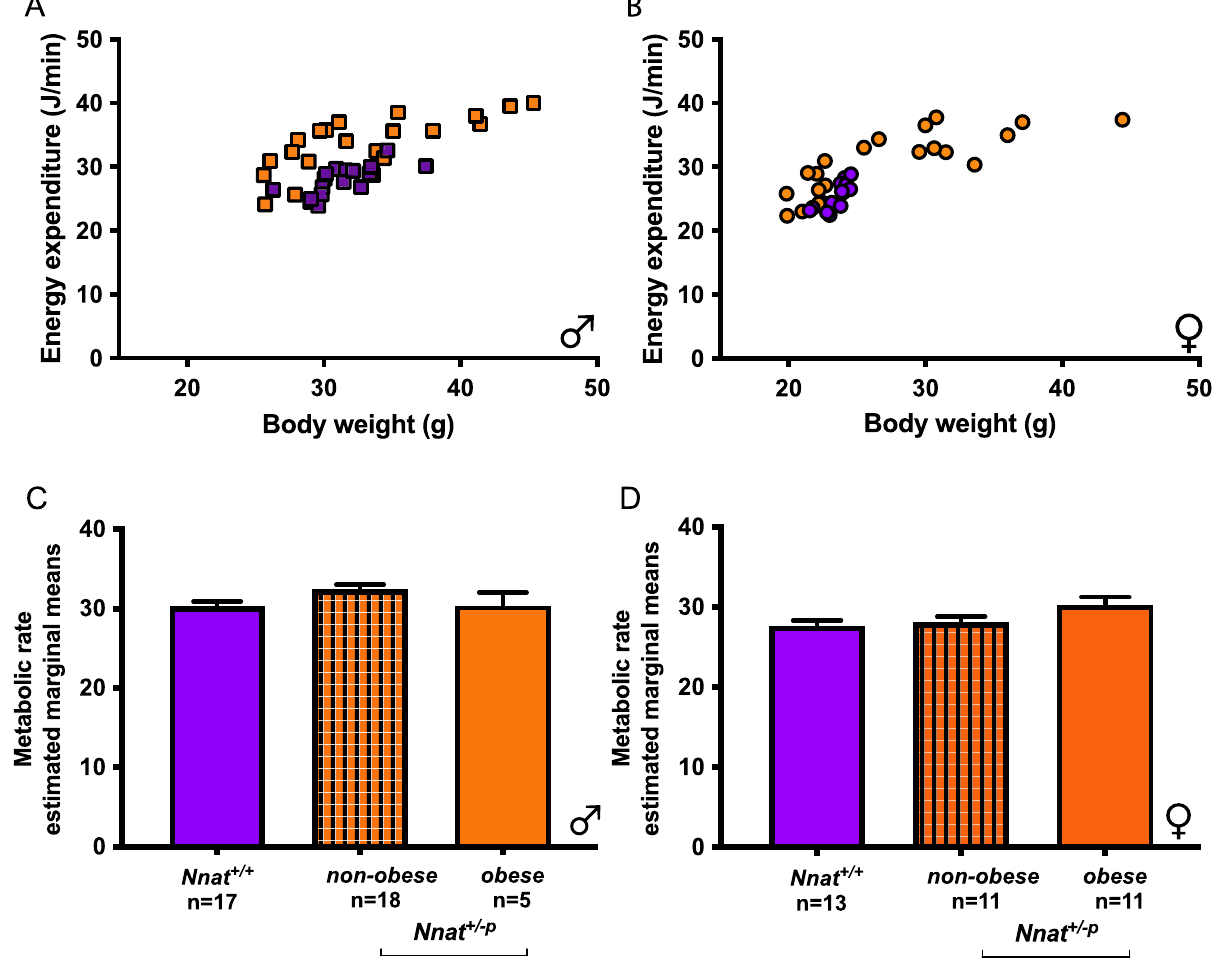
Figure 3. Nnat loss affects energy expenditure. Energy expenditure in Nnat + / + and Nnat + /−p males ( A ) and female ( B ) mice plotted against body weight (average over time in calorimetry system, mice fed on standard chow diet), wild type blue, Nnat +/−p orange. Comparison of metabolic rate corrected for body weight and dBW using ANCOVA: in male ( C ) and female ( D) mice. Data are expressed as mean ± SE, * P <